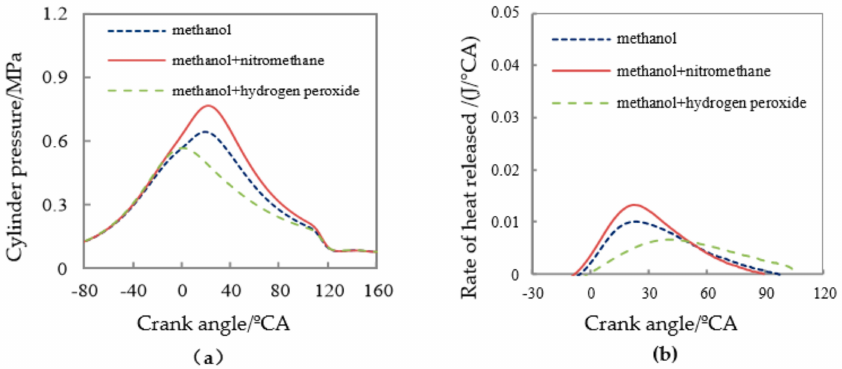
Figure 10. ( a ) Variations of cylinder pressure with di ff erent additives; ( b ) variations of the rate of heat release with di ff erent additives.